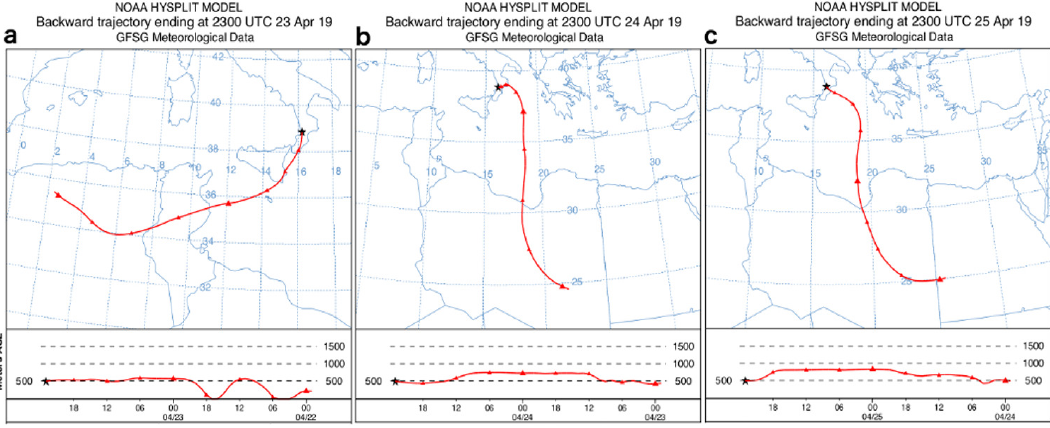
Figure 15. Back-trajectories obtained using the READY platform (https://www.ready.noaa.gov/index. php) for 23rd ( a ), 24th ( b ) and 25th ( c ) on April